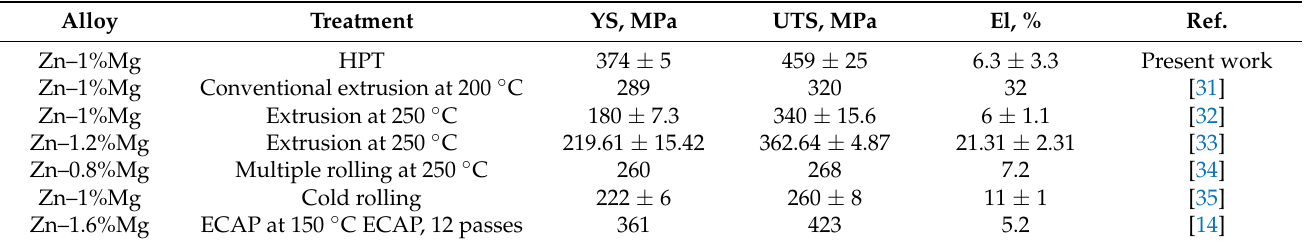
Table 4. Mechanical properties of bioresorbable Zn–Mg alloys after different deformation